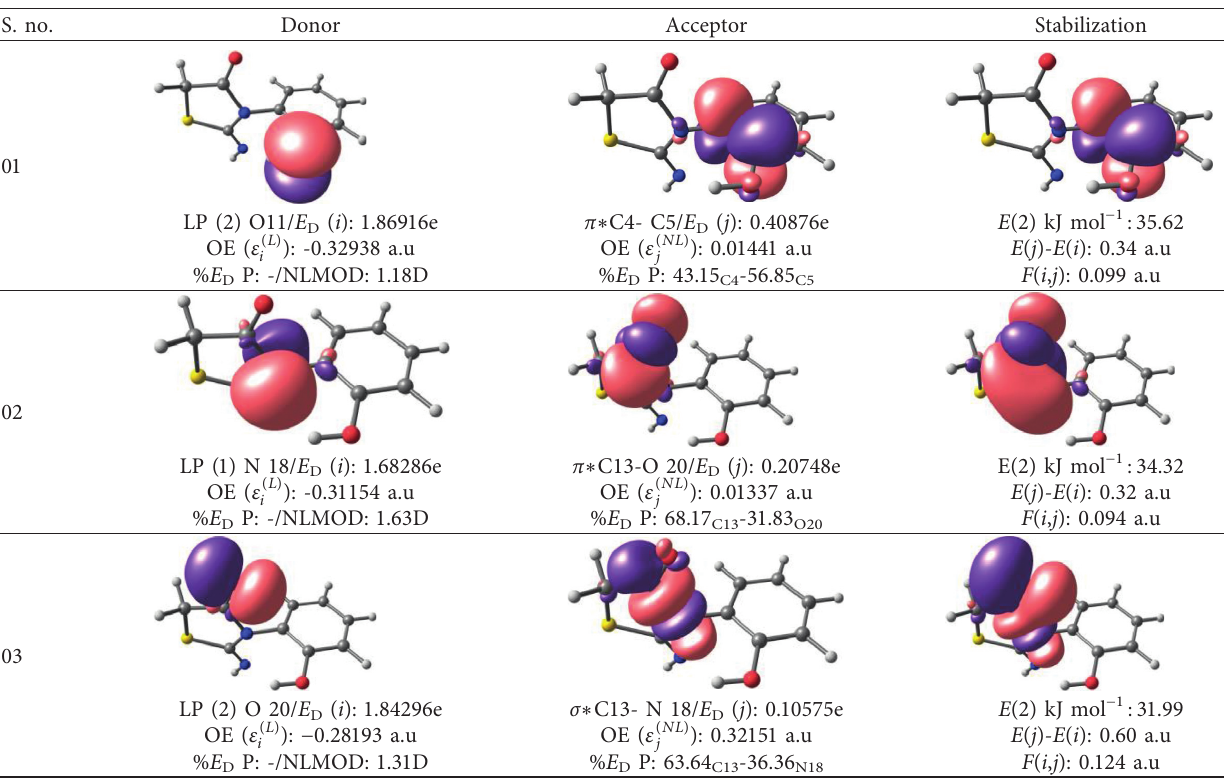
Table 6: NBO profile of